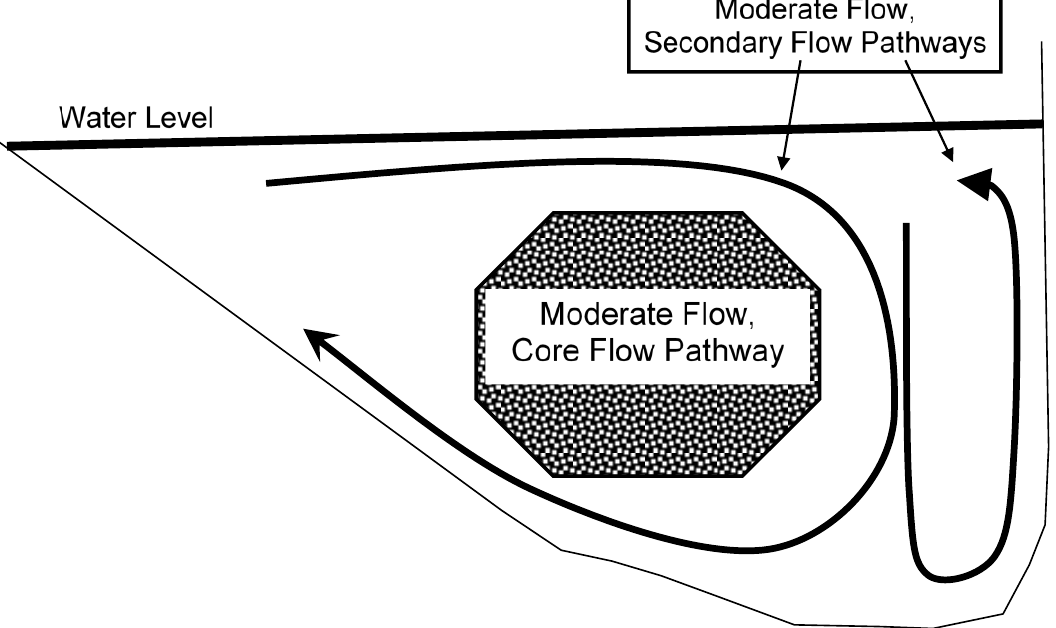
Figure 2. Our general channel cross sectional visual interpretation of Bathurst et al. (1979) [37] description of core and secondary pathways at moderate flows within a lateral scour pool reach. Illustration created by A.J.P.